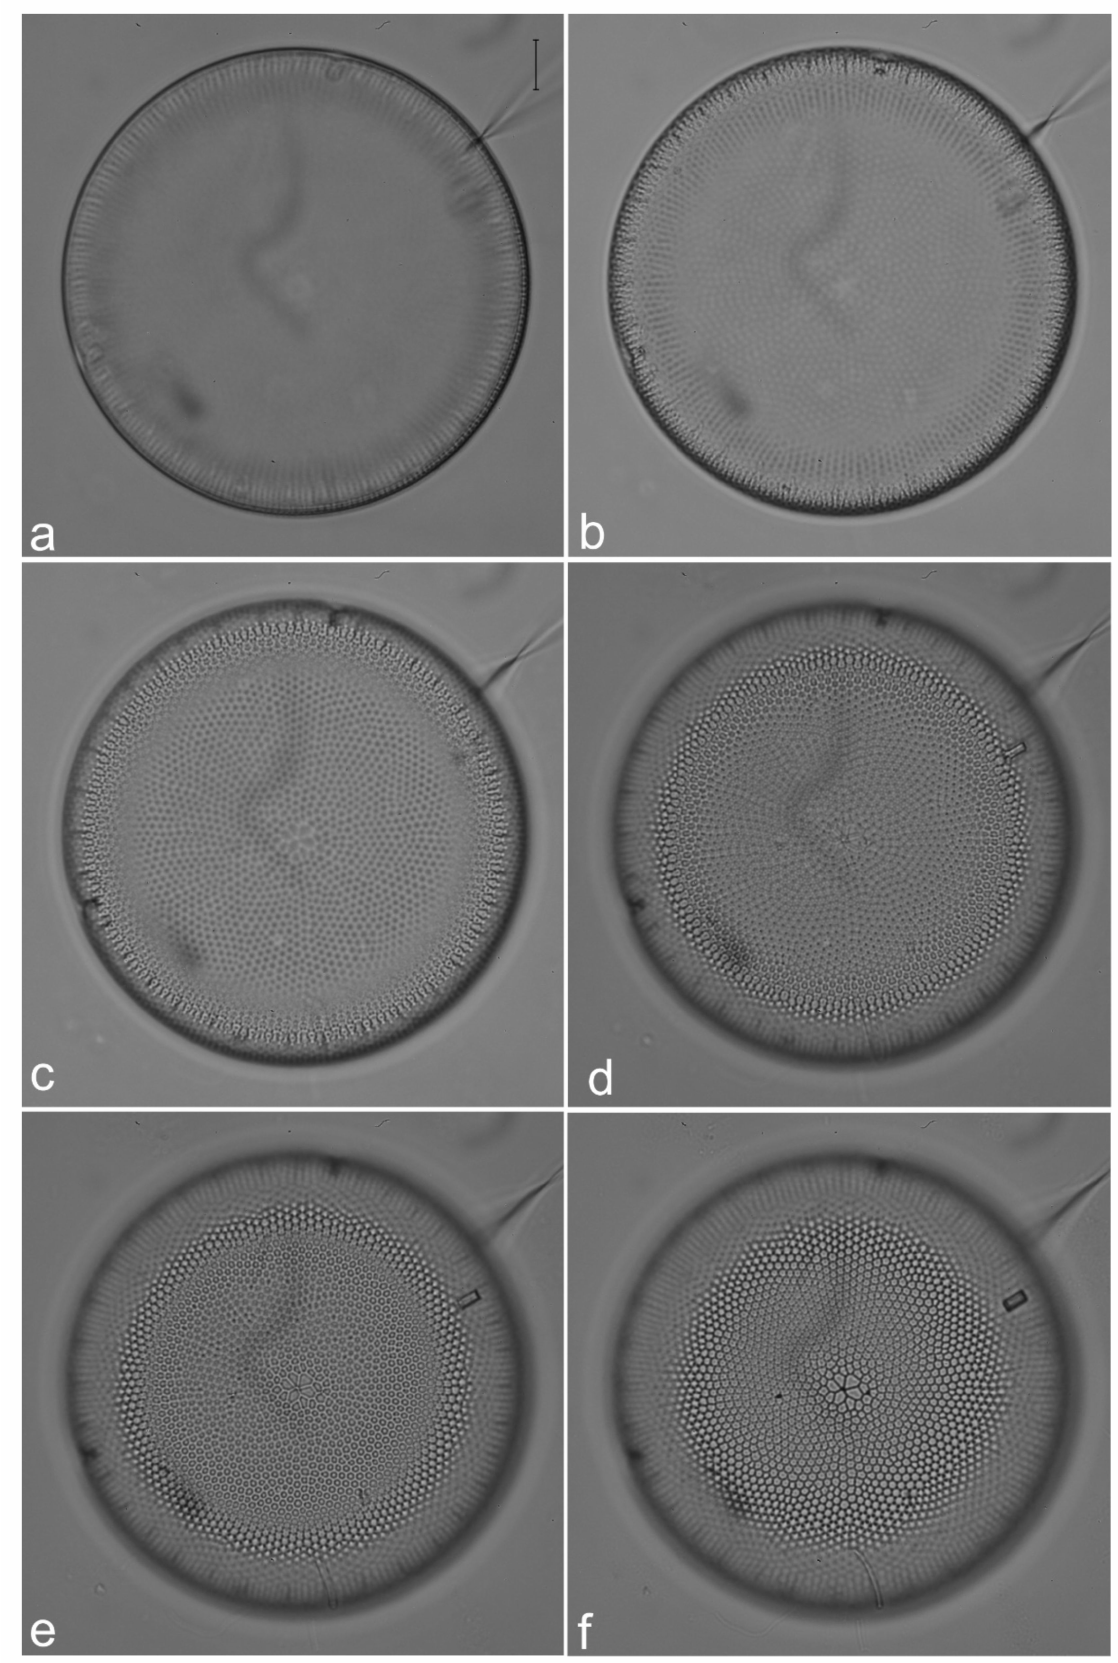
Figure 2. ( a – f ) Coscinodiscus asteromphalus in different focal planes. Scale bar = 10 µ